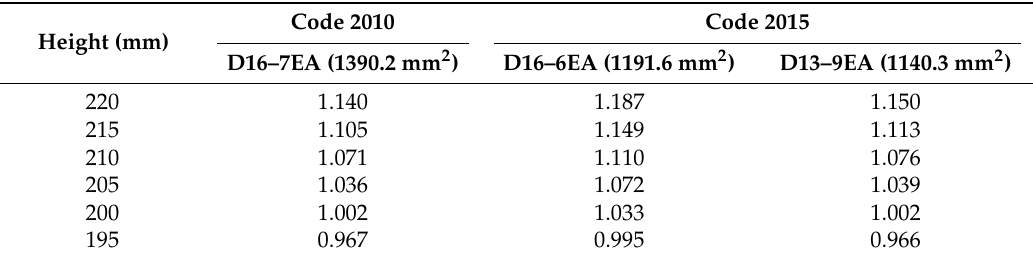
Table 6. Safety factor by height and reinforcement amount for the cross